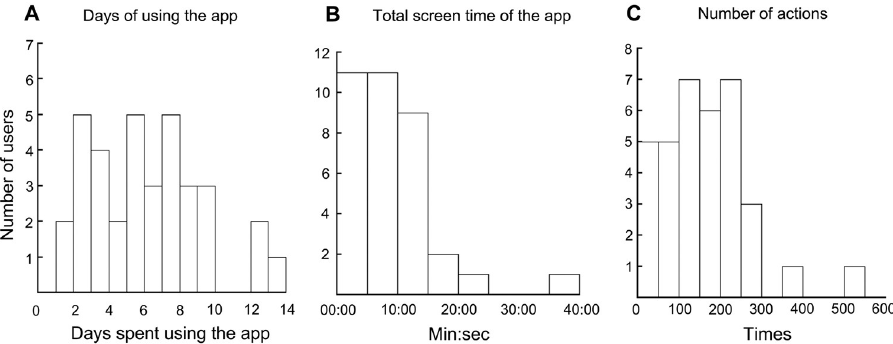
Fig 3. Histograms of log data. (A) Histogram of days spent using the app. (B) Histogram of screen time of the app. (C) Histogram of the total number of actions (screen taps or swipes).